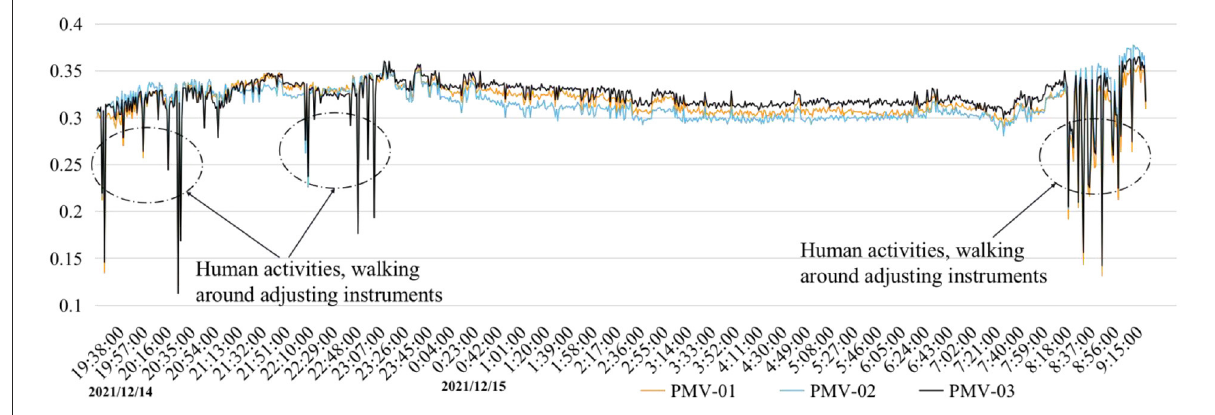
FIGURE7 Main area of activity measurement points and calculated PMV value.